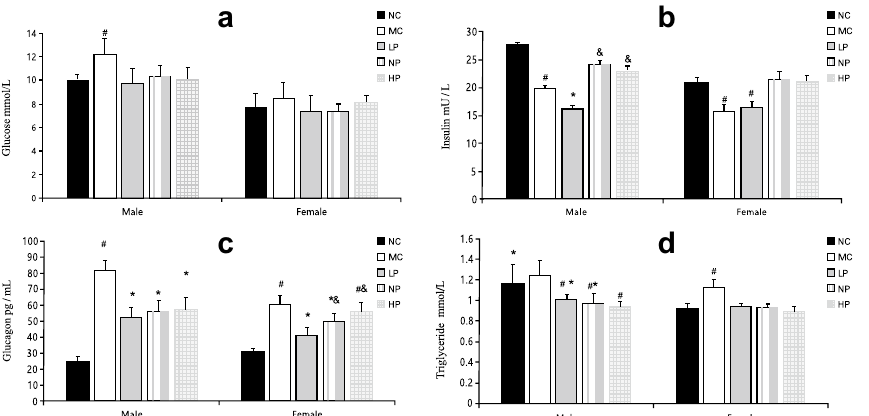
Figure 3. Concentration of glucose, insulin, glucagon and triglyceride in the plasma of different groups. ( a ) Statistical analysis of glucose. ( b ) Statistical analysis of insulin. ( c ) Statistical analysis of glucagon. ( d ) Statistical analysis of triglyceride. Mean values of the same sex with different superscript symbols (#, * and &) were significantly different ( P <